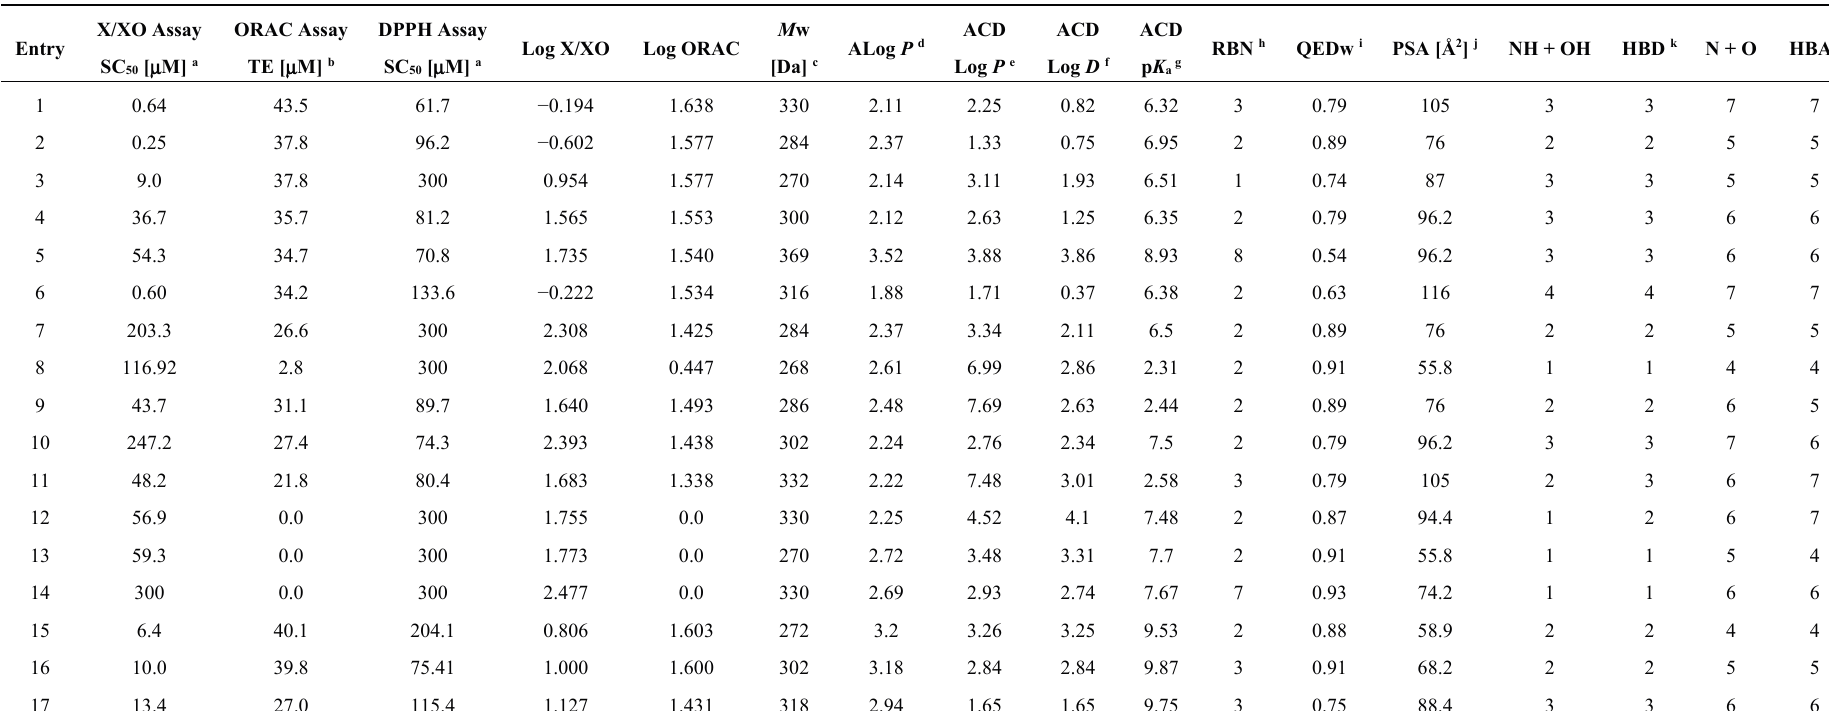
Table 2. Antioxidant activity (X/XO, ORAC, DPPH assays) of isoflavonoids from D. parviflora and ChEMBL physico/physiochemical